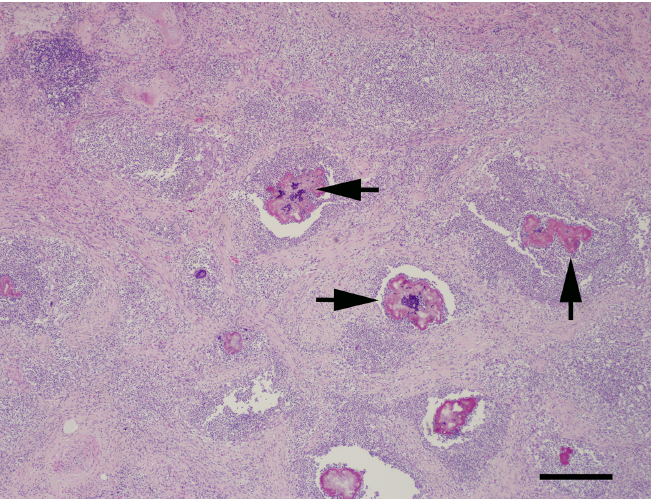
Fig 3. Hematoxalin and eosin (HE) stained section of lung from an adult female common bottlenose dolphin ( Tursiops truncatus ) that stranded in Barataria Bay, Louisiana in December 2011 with primary bacterial pneumonia. Airspaces and septae are obscured by accumulations of neutrophils and fibrous connective tissue that surround large bacterial colonies (arrows). Bar = 500 μ